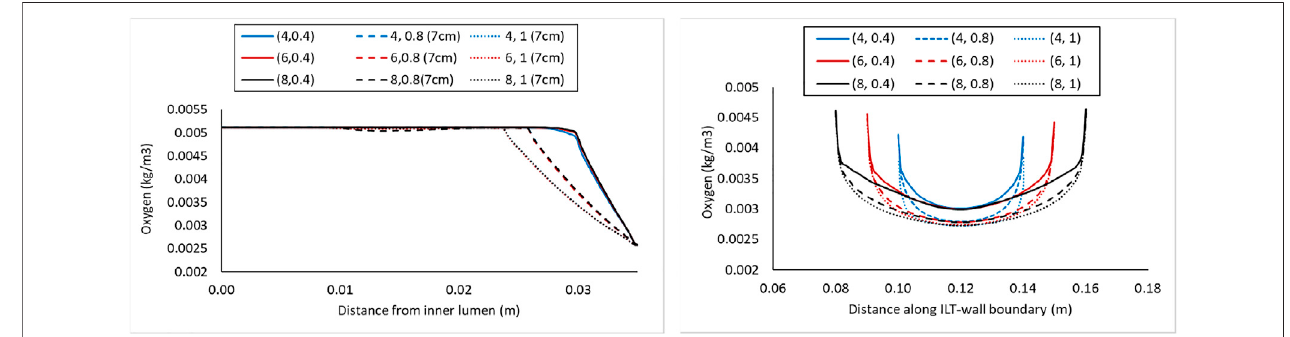
FIGURE 6 | Comparison of the oxygen concentration along a radial path line at halfway along the length of the lumen in the cases with BD = 7 cm and varying ILT length( l )and ILTthickness( δ ) denoted bycase ( l , δ ) (left),and comparison oftheoxygenconcentrationalongtheaxial lengthon theinteriorinterfaceofthearterialwall in the same cases (right). In both plots, the blue, red, and black lines represent the short, medium, and long ILT cases information respectively; and solid, dashed, and dotted lines represent thin, moderate, and thick ILT cases respectively. Cases are presented in Figure 2 . Path lines are demonstrated in Figure 4